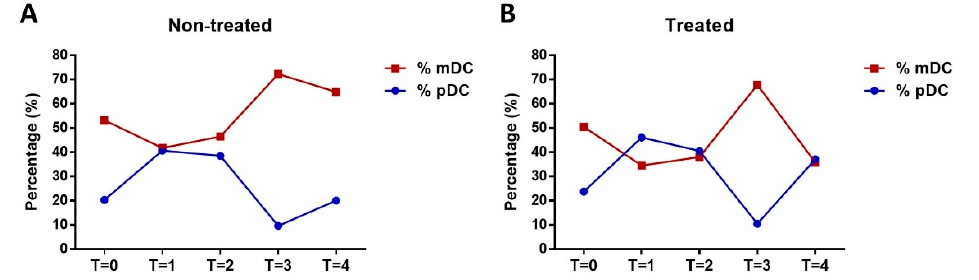
Figure 4. Molecule expression in monocytes analyzed at different monitoring points (T0 to T4), showing percentage of monocyte subsets before, during, and after testing. ( A ). CD14++CD16 − ( B ). CD14++CD16+ ( C ). Pro-inflammatory CD14LowCD16+.